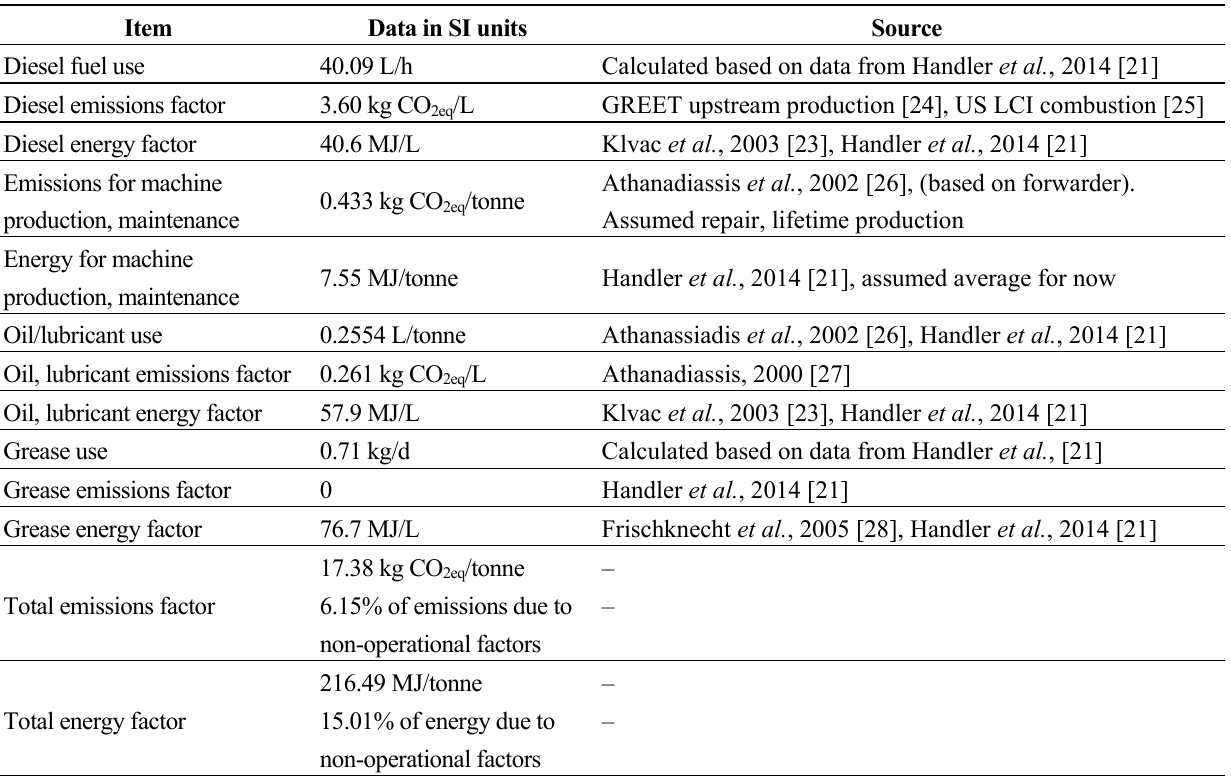
Table 3. Data and assumptions for forest biomass